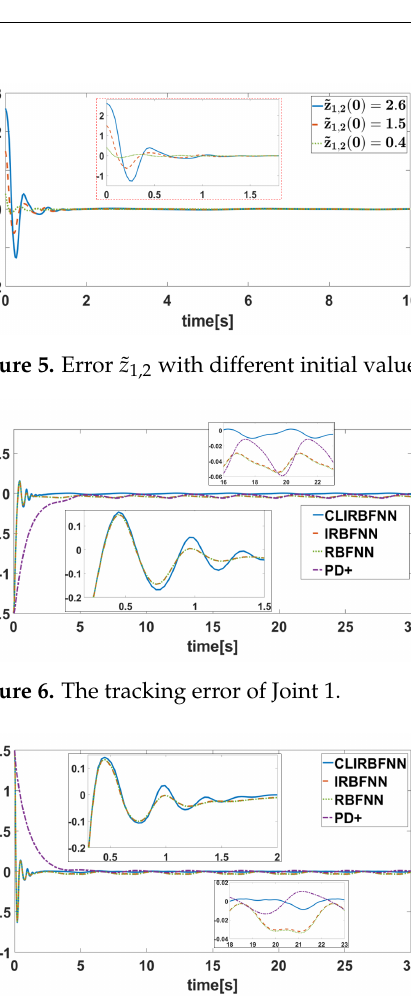
Figure 7. The tracking error of Joint 2.